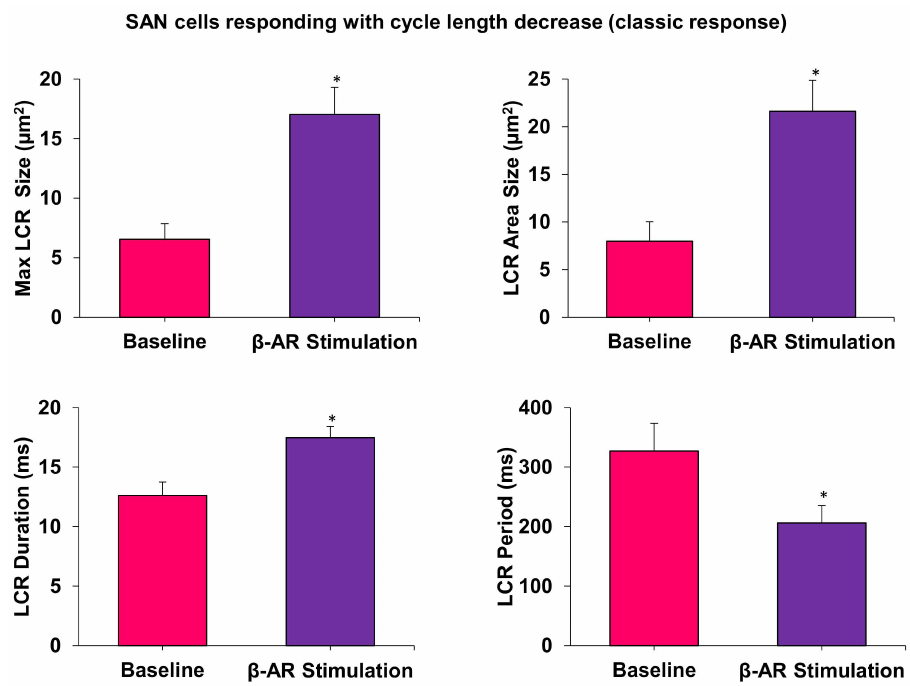
Figure 5. All measured LCR characteristics substantially and significantly changed in cells with a cycle length decrease (rate increase, i.e., the classic response). * p < 0.05, n = 4